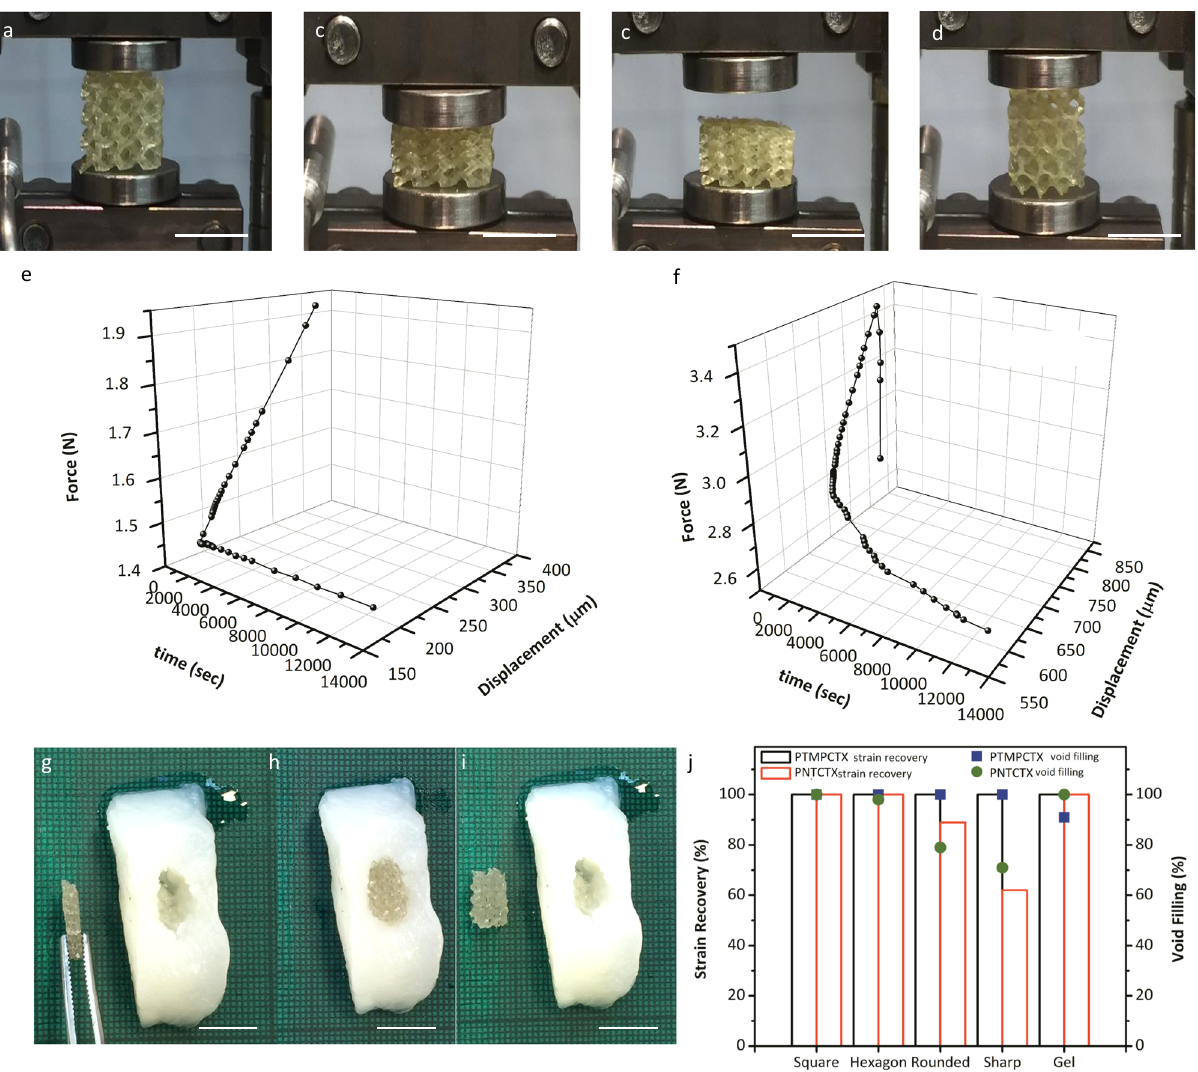
Fig. 5 Shape memory behavior. Representative shape memory behavior for a printed porous polyNTC scaffold as it is transitioned from its original geometry ( a ) to a compressed state under loading (~50% strain, b ), after which it is cooled to 25 °C and will retain its secondary shape after the deformation load is removed ( c ), and the return to the original geometry upon heating of the sample ( d ). The expansion forces of the PTMPTCX ( e ) and PNTCTX ( f ) using compression kinetic studies under in vitro conditions. In vitro void- fi lling behavior was further examined using compressed scaffolds (represented by PNTCTX here) in soft alginate molds, displaying shape fi xation ( g ), void fi lling without deformation of the alginate ( h ), and shape fi xation to the void shape even after removal of the scaffold ( i ); 3D-printed molds were further examined for void- fi lling ef fi ciency and strain recovery ( j ). (All scale bars = 1